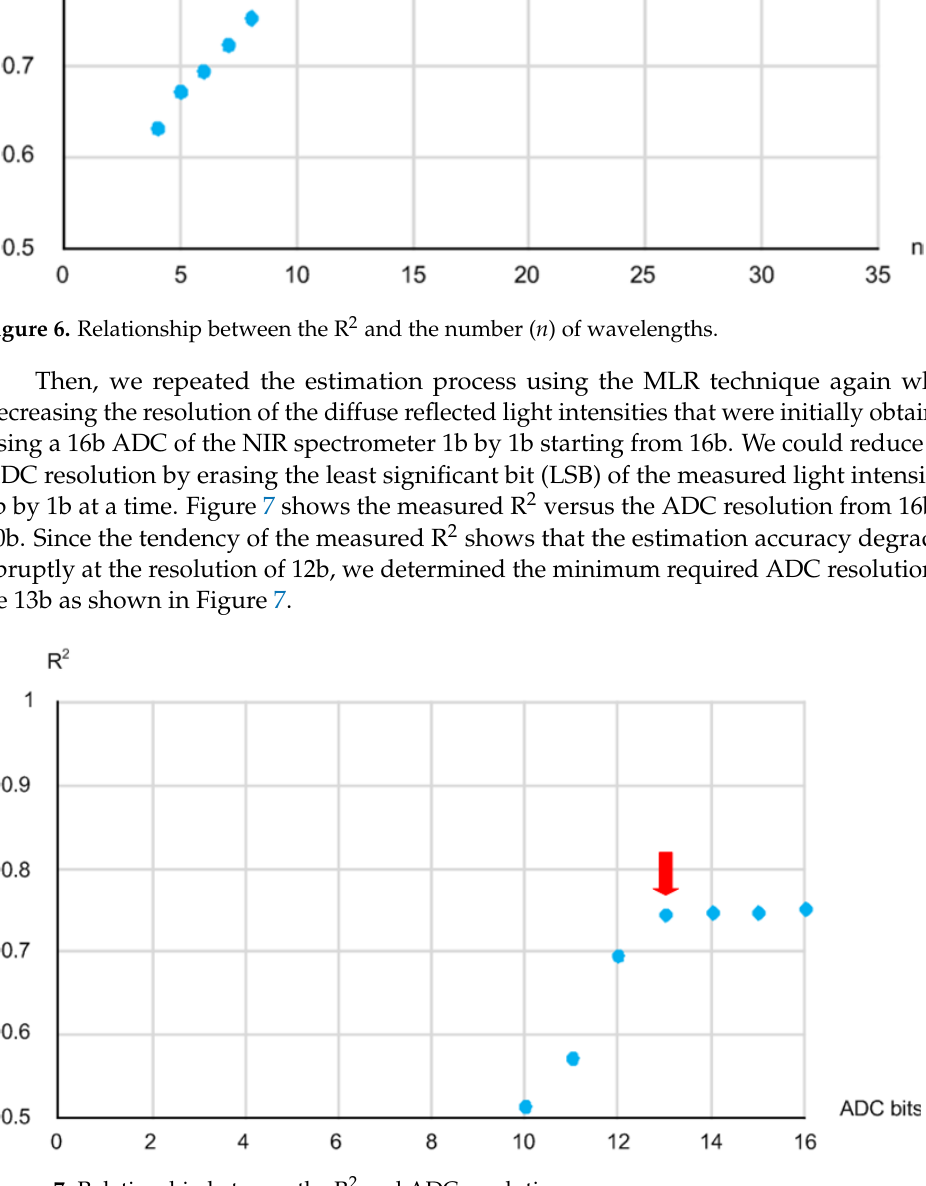
Figure 7. Relationship between the R 2 and ADC resolution.